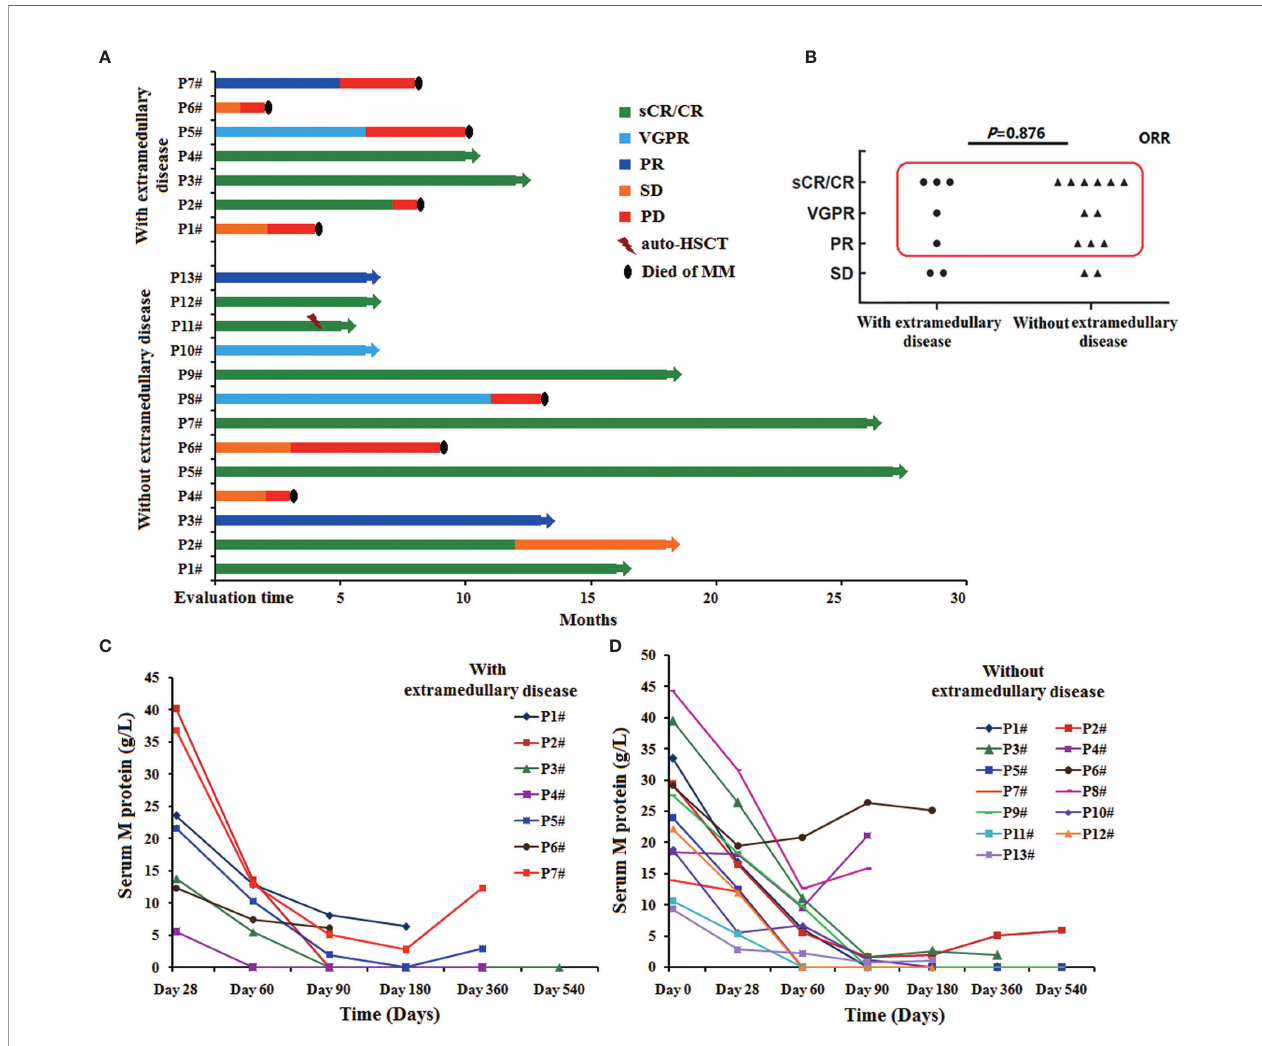
FIGURE 1 | Clinical responses of the humanized anti-BCMA CAR-T cell therapy. (A) Pt with 1,2,5,6,7 (5/7, 71.4%) and Pt without 4,6,8 (3/13, 23.1%) developed disease progression again and died of their primary disease. (B) There was no difference in ORR between patients with and without extramedullary disease when they achieved the best effect ( P =0.876). (C) M protein levels increased again in Pt with 5,7 when their disease progressed again, but it did not increase when the disease of Pt with 1,2,6 progressed again. (D) All the patients with disease progression were accompanied by an increase of M protein